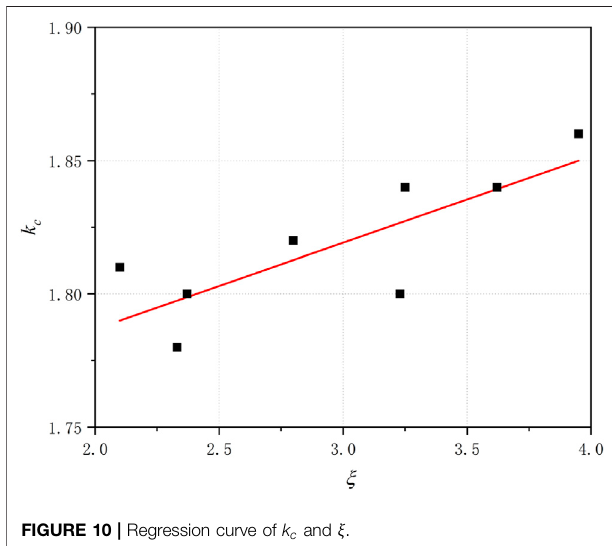
FIGURE 10 | Regression curve of k c and ξ